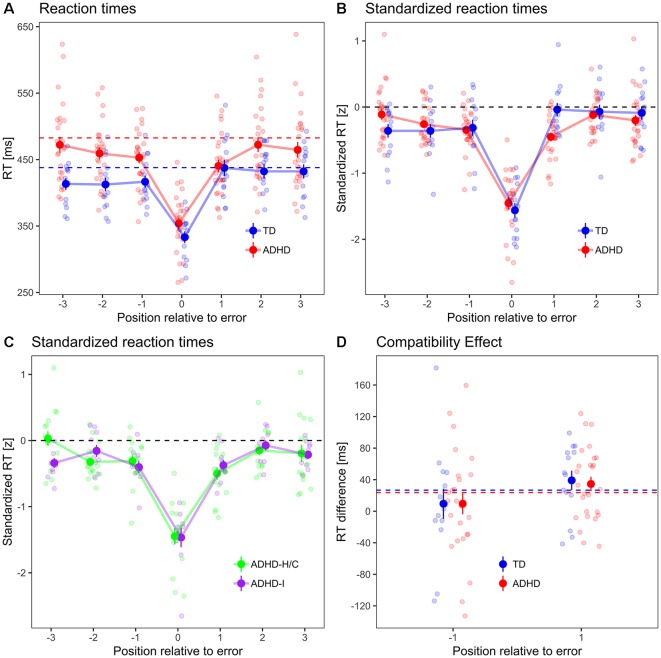
(A) Peri-error RTs, (B) standardized RTs, (C) standardized RTs in ADHD subtypes. Dots with error bars indicate mean ± standard errors of RT in error trials and in three preceding and subsequent trials, respectively, for typically developing (TD) controls (blue) and ADHD patients (red). Dashed lines indicate the mean error-free RT for each group (which is, by definition, zero for standardized RT). Small dots in the background indicate participant-wise mean values. (D) Compatibility effect in ER−1 and ER+1 trials. Dashed lines indicate compatibility effect from error-free trials in both groups.